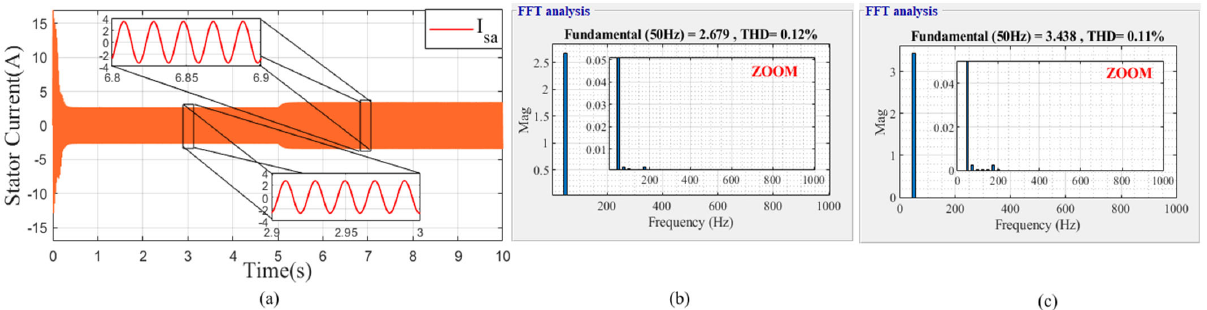
Figure 20. Performance with IR bearing defect of IM without control: ( a ) Stator current and ( b ) THD at no ‐ load and ( c ) THD with load (5 Nm).